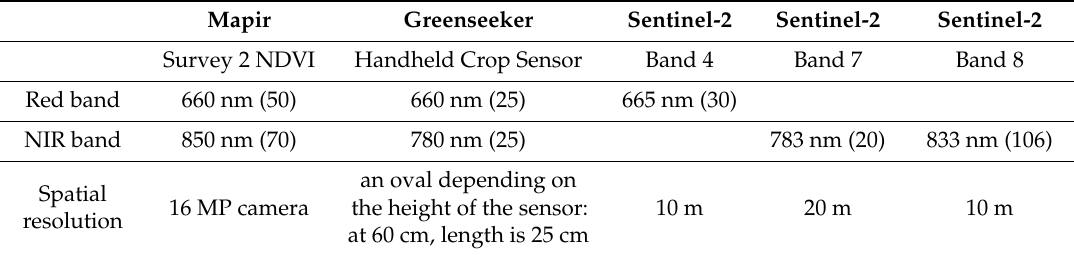
Table 2. Comparison of spectral properties of the various NDVI devices listed in Table 1. Numbers in parentheses show the bandwidth in